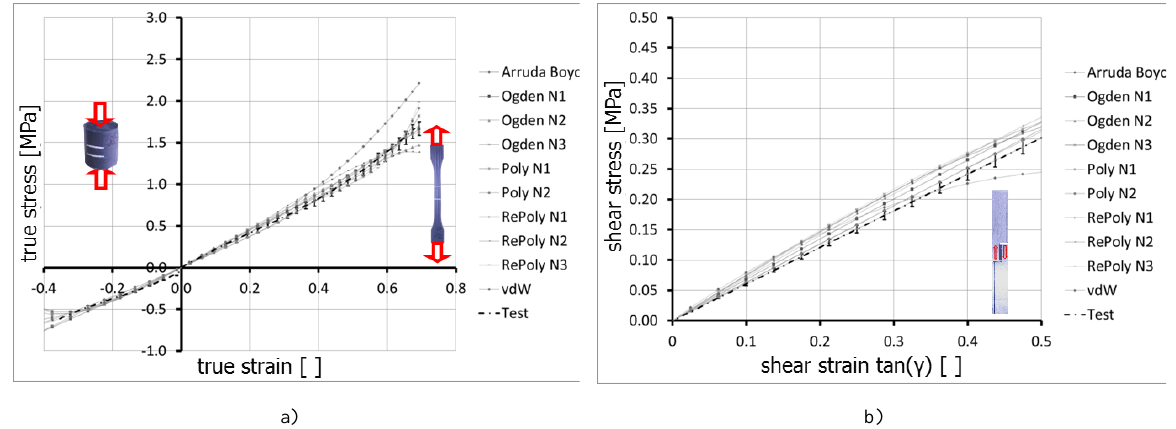
Fig. 3 Stress-Strain behavior for the considered hyperelastic models compared with the experimental